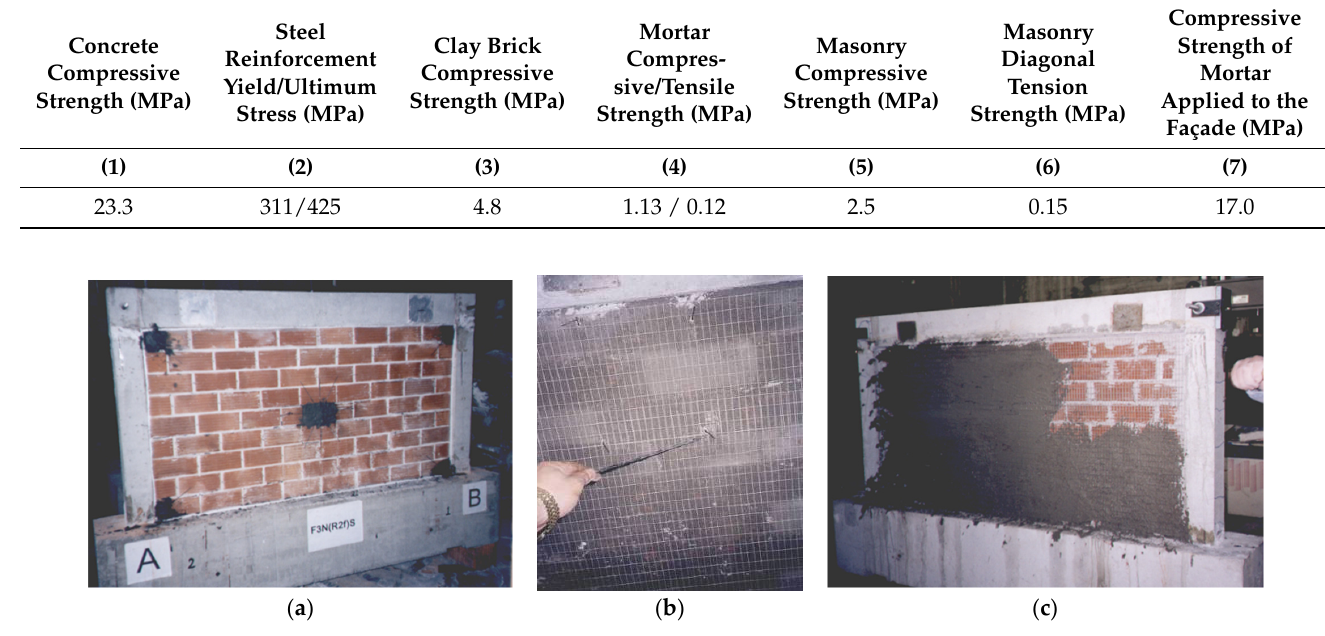
Figure 7. RC frame + UMI specimen F3NP [23] ( a ) before applying the mortar facades. ( b ) attaching the wire net. ( c ) applying the cement mortar hosting the wire net to produce (Last row of Table 2). Table 2. Summary of the obtained peak response of the bare and the infilled specimens.